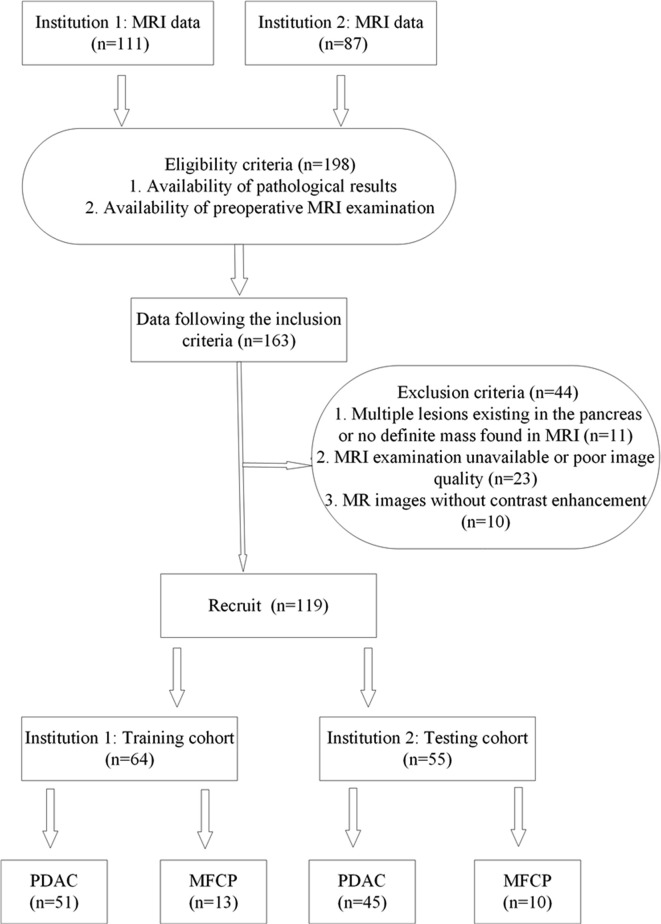
The flowchart of patient enrollment in our study. MRI, magnetic resonance imaging; PDAC, pancreatic ductal adenocarcinoma; MFCP, mass-forming chronic pancreatitis.